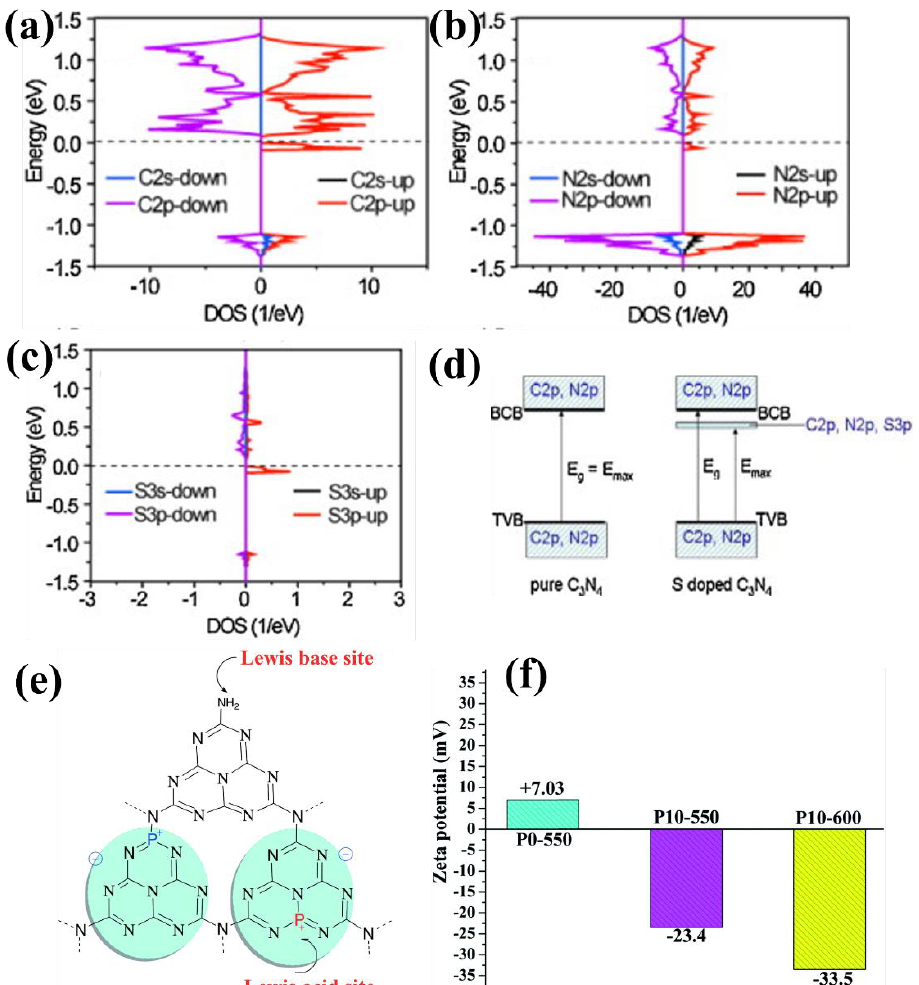
Figure 4. ( a – c ) Partial DOS of the S-doped CN. ( d ) Schematic of band structure of pure CN and S-doped CN [46]. ( e ) Schematic diagram of possible existing forms of P atoms in CN and their effects on electronic properties. ( f ) Zeta potentials of the pure CN (P0-550) and P-doped CN (P10-550, P10-600) [47].